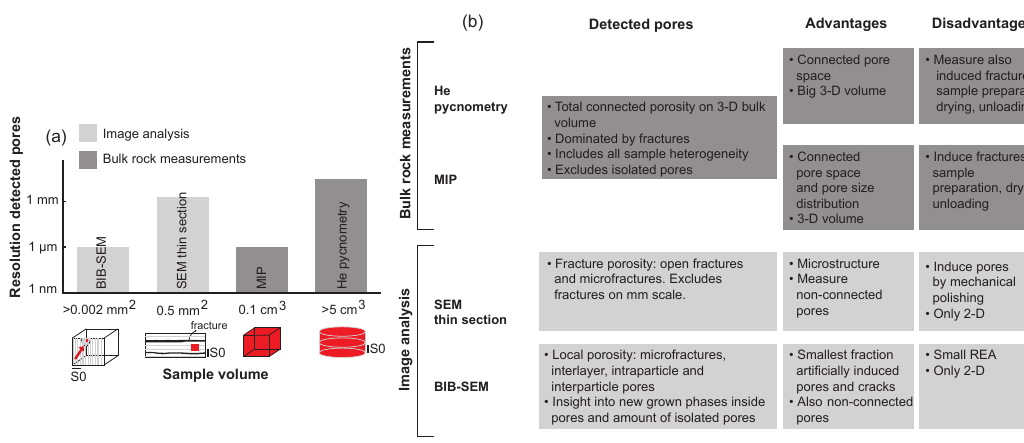
Figure 2. Overview of analytical techniques, S0: bedding, BIB-SEM: broad ion beam scanning electron microscopy, SEM: scanning electron microscopy, MIP: mercury intrusion porosimetry, and REA: representative element area. (a) Sample volume vs. resolution of detected pores. (b) Different techniques with advantages and disadvantages.